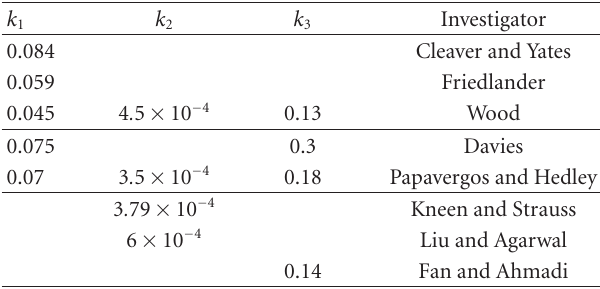
Table 1: Recommended values of k 1 , k 2 and k 3 for (1),